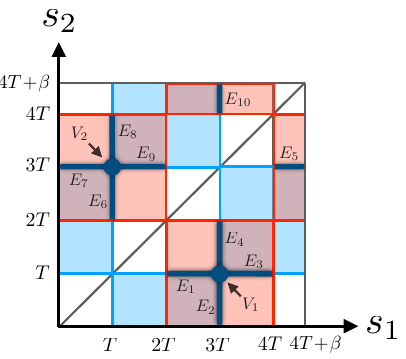
Figure 4 . Edges E and vertices V contributing non-trivial boundary terms to the